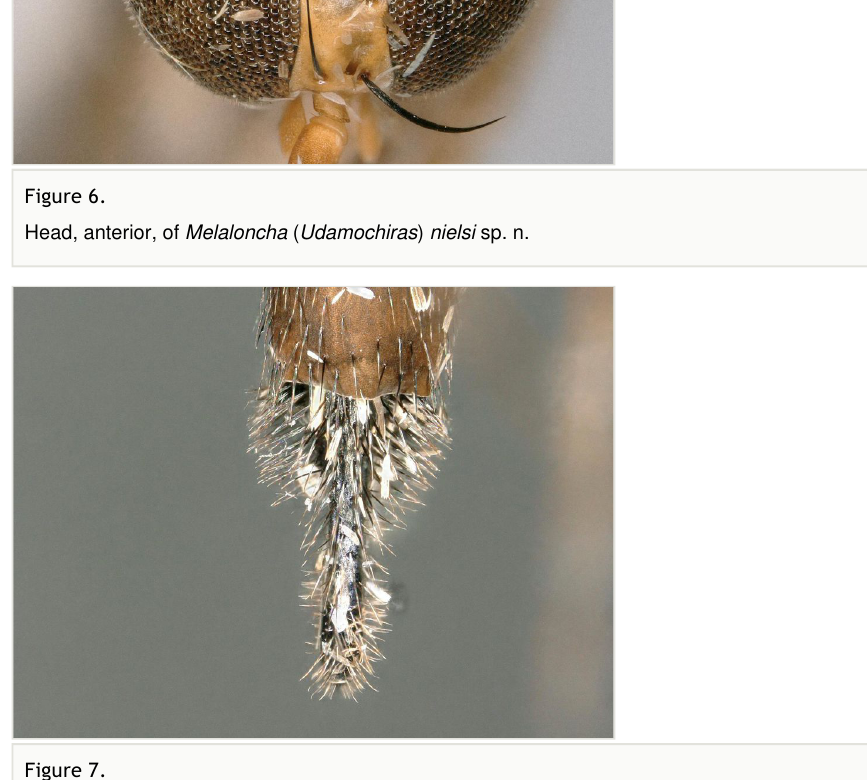
Diagnosis Large dark species with oviscape densely setose at base, laterally flattened, dorsal surface curved ventrally. In the key to species (Brown 2004a), M. nielsi comes closest to M. valeria Brown, from which it differs by the dense black setae (absent from M. valeria ) and greatly compressed structure of the oviscape. It does not resemble any of the more recently described species of Melaloncha ( Udamochiras ) (Gonzalez and Brown 2004, Brown 2009, Braet 2013).